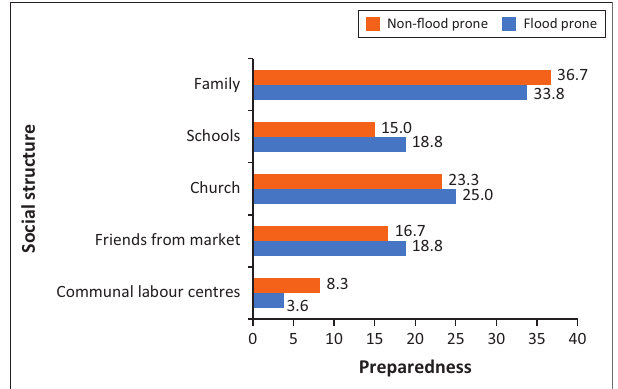
FIGURE 3: Social structures that enhance